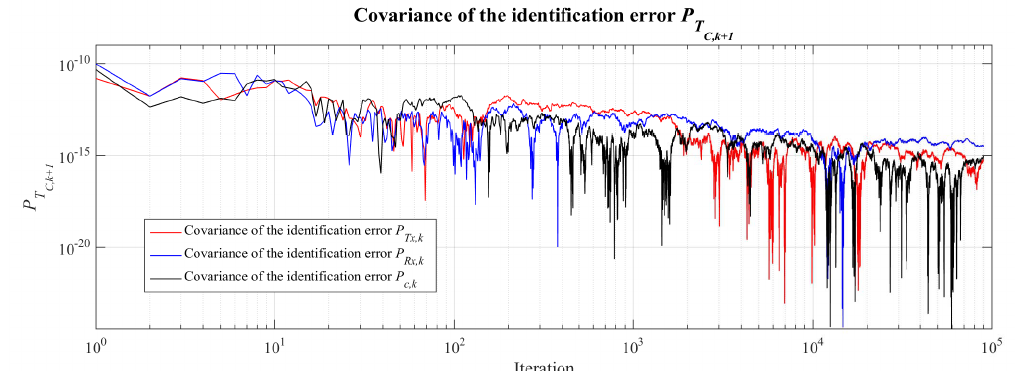
(using log scale on C , k + 1